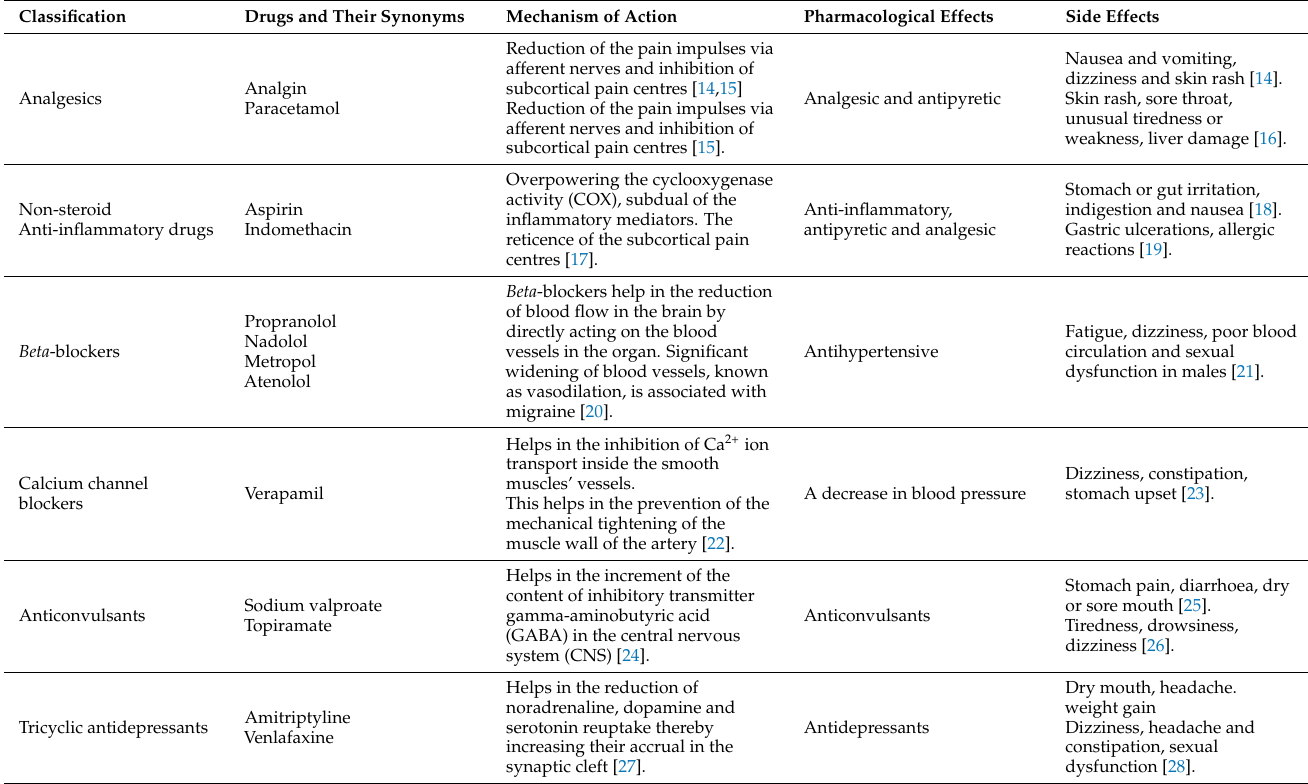
Table 1. Orthodox conventional medicines used in the management of